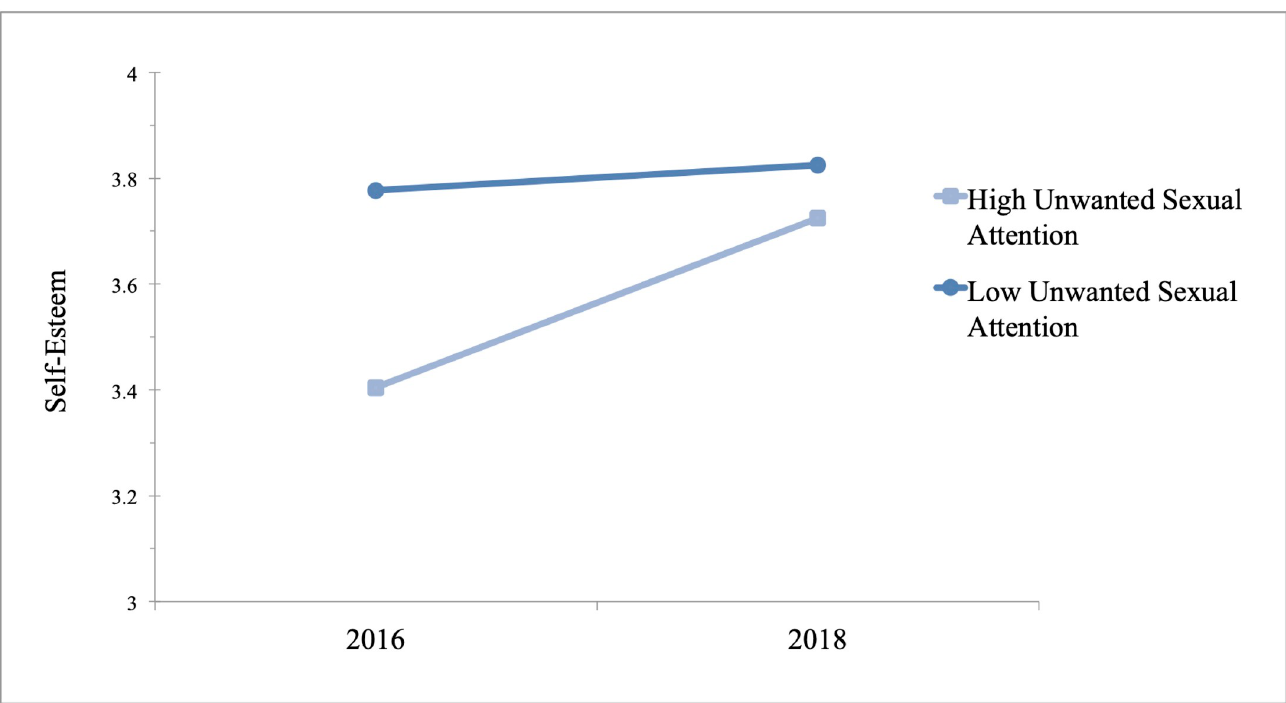
Fig 2. Coefficient estimates for relationship between unwanted sexual attention ( ± 1 SD) and self-esteem before and in 2018. Estimates are derived from GLM using data from 513 women, 250 of whom were surveyed in September 2016 and the remaining women were surveyed in September 2018.